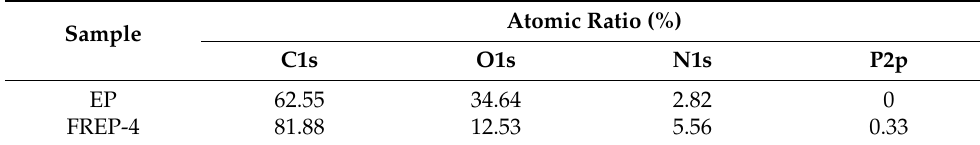
Figure 3. Digital photos and SEM micrographs of char residues after CCTs: ( a 1 – a 3 ) pure EP; ( b 1 – b 3 ) FREP-2; and ( c 1 – c 3 ) FREP-4. Table 6. Element compositions of the char residues.